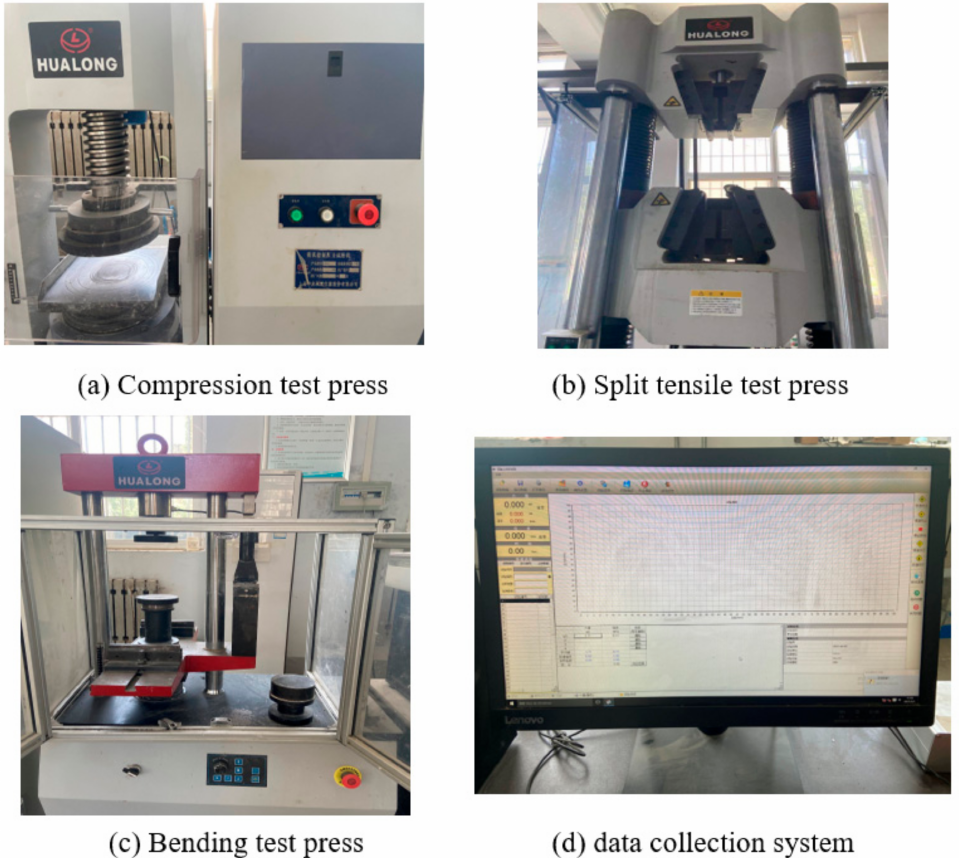
Figure 2. Press and data acquisition system: ( a ) compression test press; ( b ) split tensile test press; ( c ) bending test press; ( d ) data collection